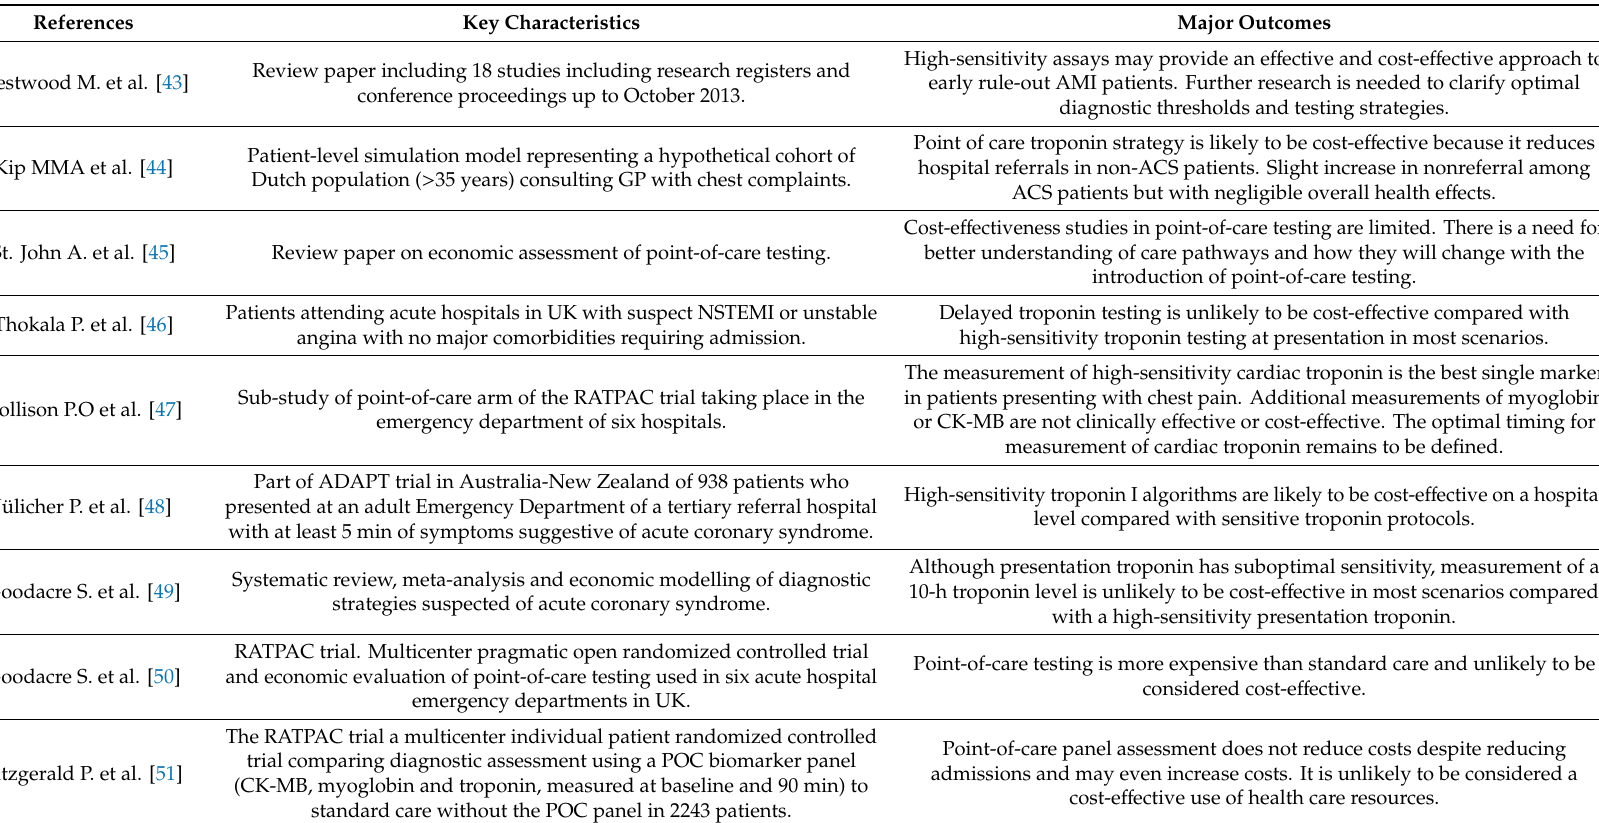
Table 2. Summary of the review process regarding cost-e ff ectiveness of troponin-based